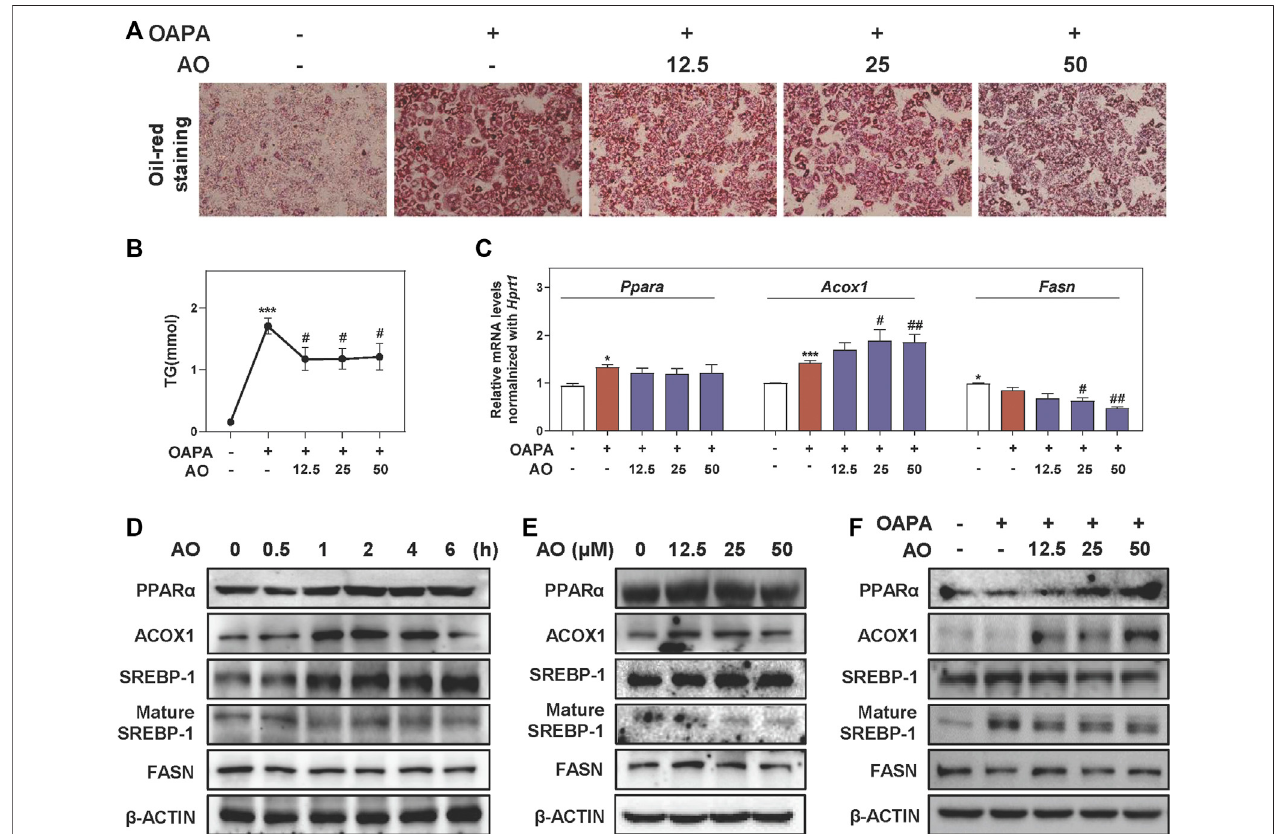
FIGURE 3 | AO alleviates lipid accumulation in fat-overloaded MPHs. MPHs were incubated with OAPA (OA: 250 μ M, PA: 500 μ M) and treated with different dosages (12.5, 25 and 50 μ M) of AO for 24 h (A) Representative images of oil red O staining of MPHs (B) TG levels of MPHs (C) Relative mRNA levels of Ppara , Acox1 and Fasn inMPHsweredetermined byqPCRandnormalized using Hprt1 asaninternalcontrol (D) MPHsweretreatedwithAO(25 μ M)atdifferenttimepoints (E and F) MPHsweretreatedwithdifferentconcentrationsofAOfor24 hwithorwithoutOAPA (D,E and F) TheproteinlevelsofPPAR α